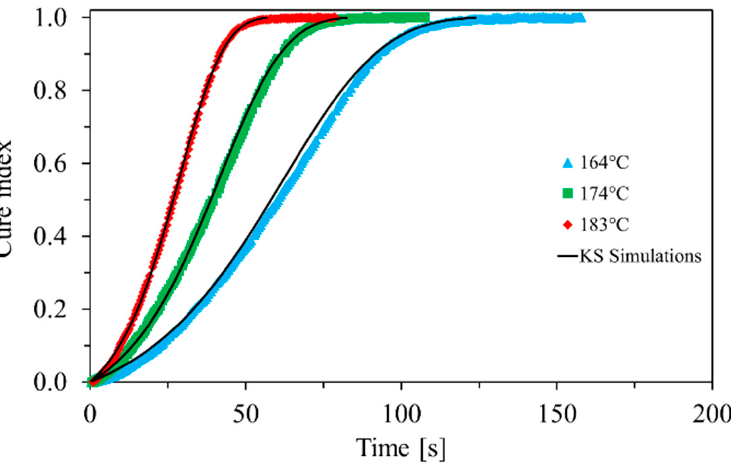
Figure 7. Comparison of Kamal-Sourour simulations (black lines) and measured data (red, green and blue dots).